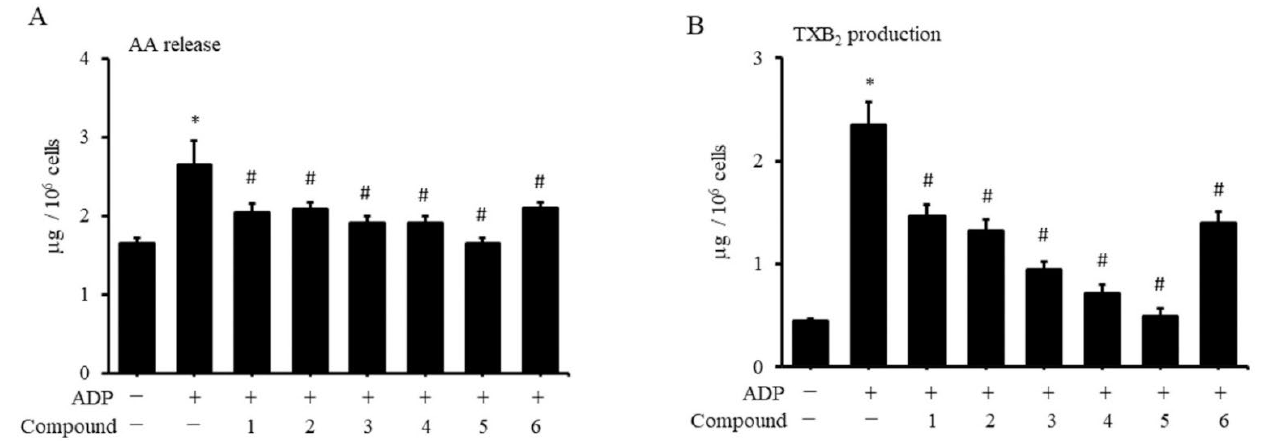
Figure 4. Effects of coumarin derivatives on the release of AA and TXA2 from human platelets. Human PRP was treated with 10 ppm of coumarin derivatives for 1 h. Purified plates were isolated, and 10 μM ADP and 3 μM fibrinogen were added for 30 min. Contents of AA ( A ) and TXA2 ( B ) were analyzed using an enzyme immunoassay ( n = 3). * p < 0.05 compared with the control group. # p value < 0.05 for PRP treated with indicated compound followed by ADP stimulation compared